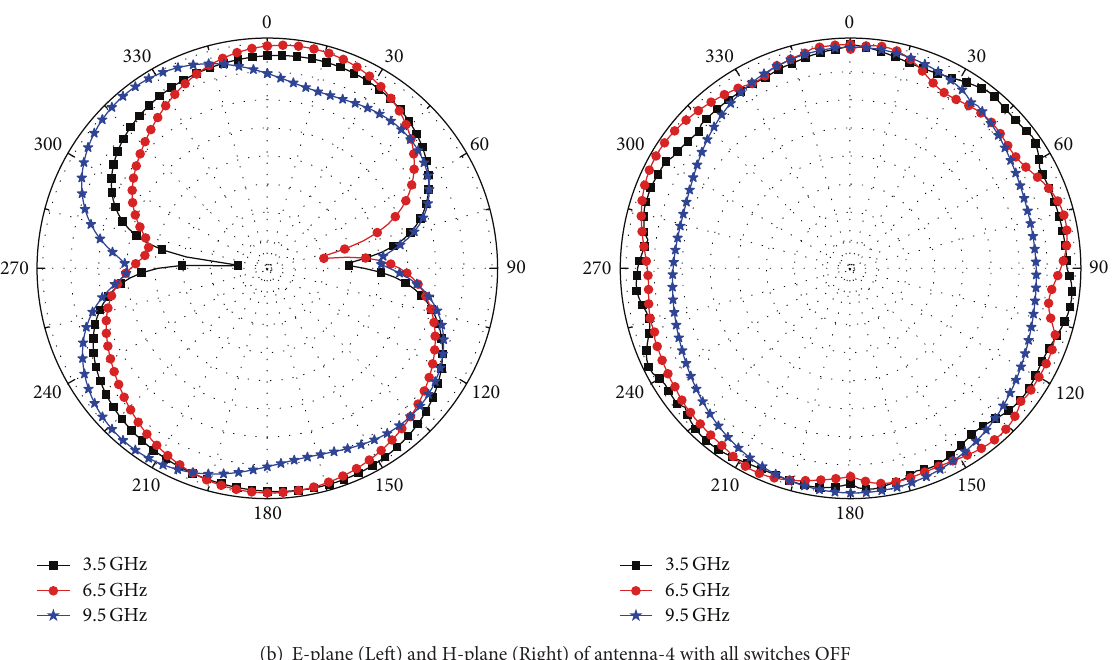
Figure 8: Radiation patterns of the fabricated